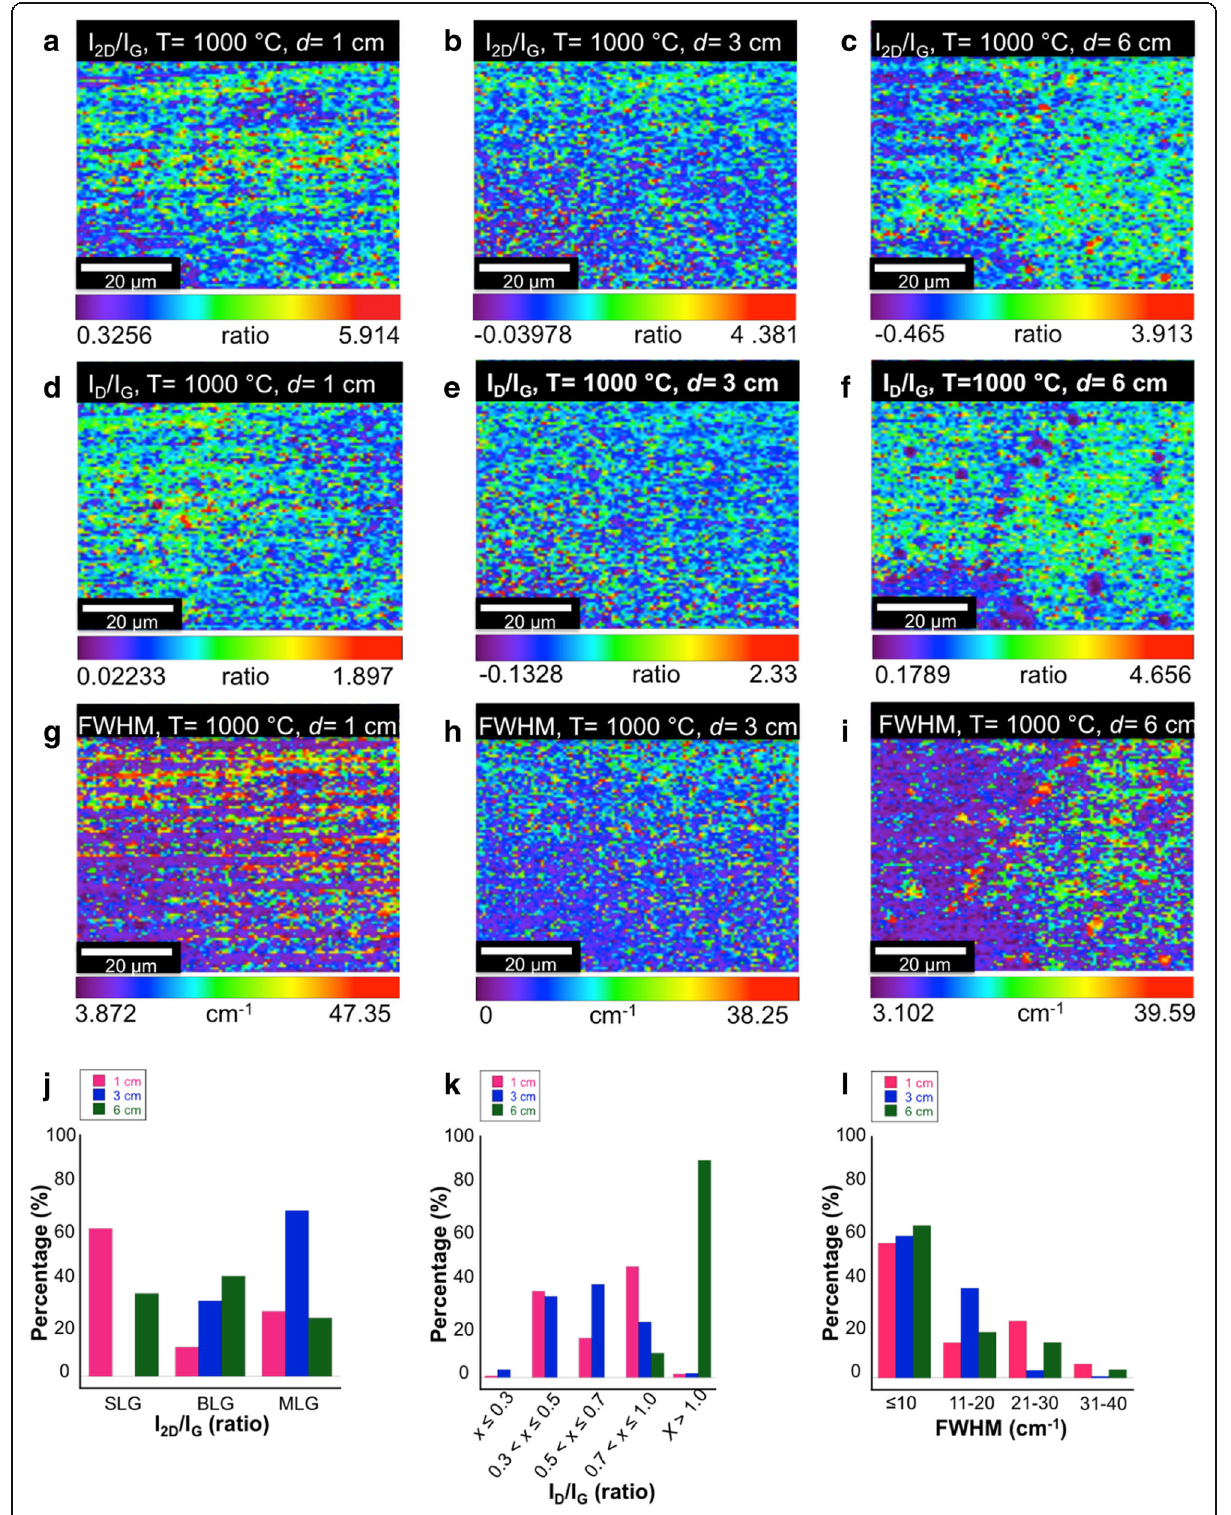
Fig. 5 Raman mapping images of graphene on Cu substrate for a – c I 2D / I G , d – f I D / I G , and g – i FWHM value of 2D band, for 1cm, 3cm, and 6cm. Also, the histograms to indicate the distribution percentage of the intensity ratio, j I 2D / I G , k I D / I G , and l FWHM value of 2D band. Growth temperature